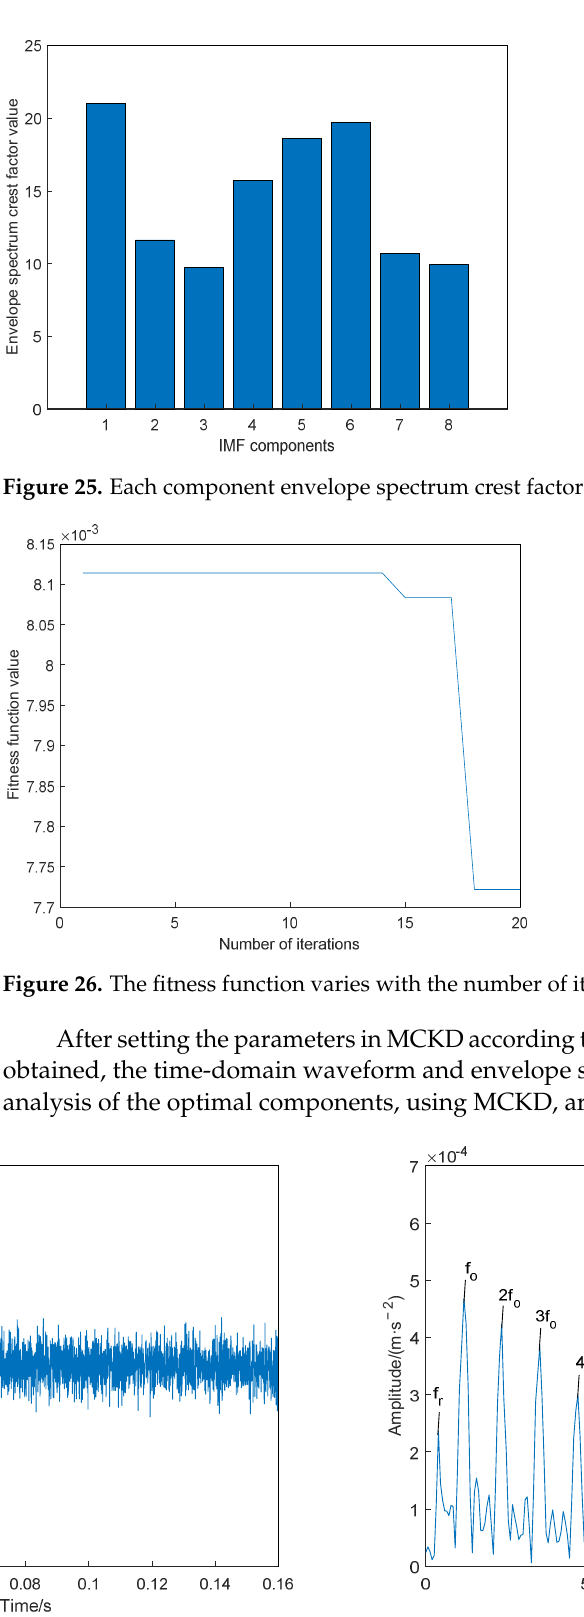
Figure 27. Time-domain waveform and envelope spectrum after MCKD processing: ( a ) time-domain graph after MCKD processing; ( b ) envelope spectrum after MCKD processing.